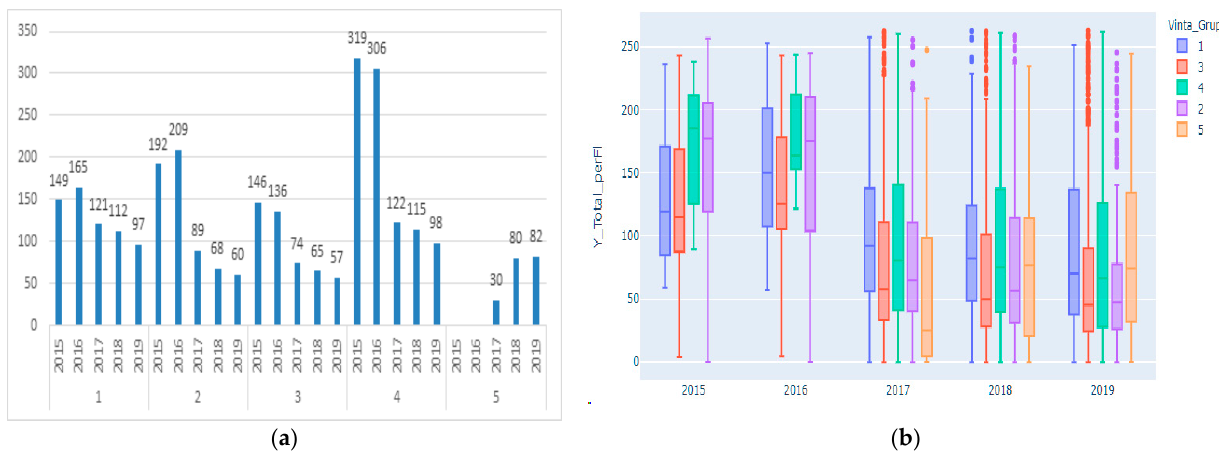
Figure 7. ( a ) Visualization of the bar chart in Table 5; ( b ) Visualization of the box plot in Table 5; Ascertainment of the decreasing trend in the median (kW/m2y) in the amounts of energy usage by year from 2017, as compared to 2015 and 2016